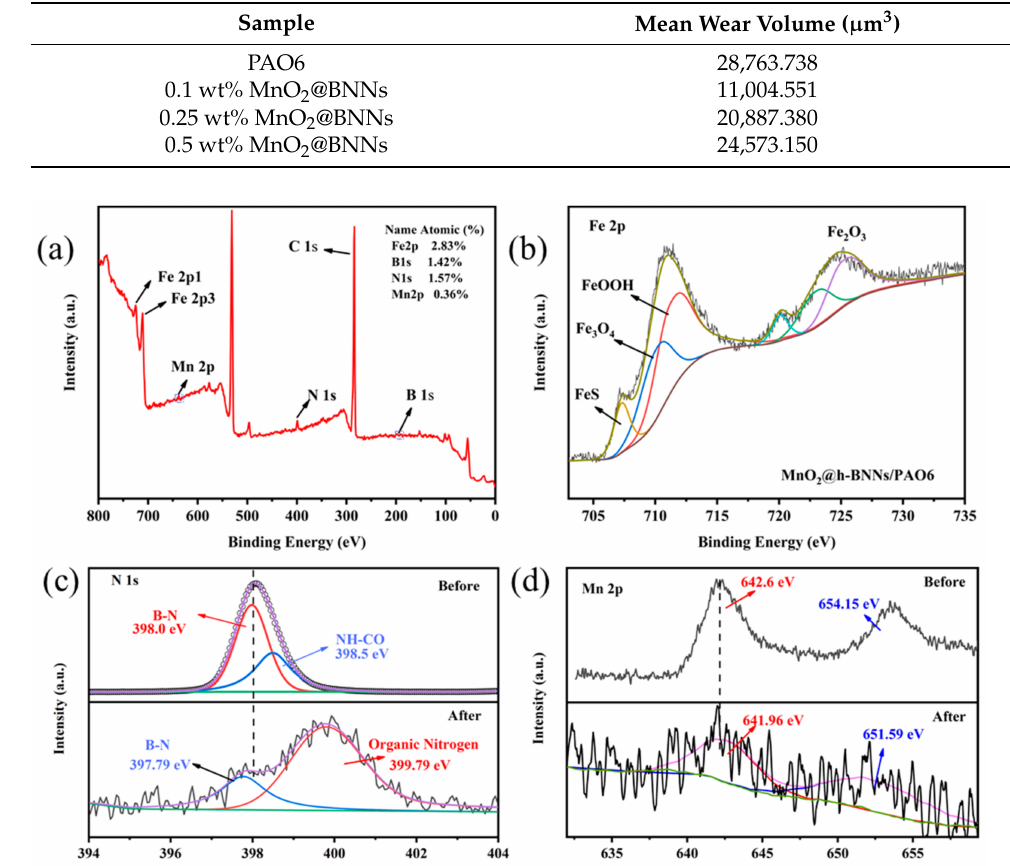
Table 1. Wear volume of lubricating oil with different contents of MnO 2 @BNNs/PAO6.